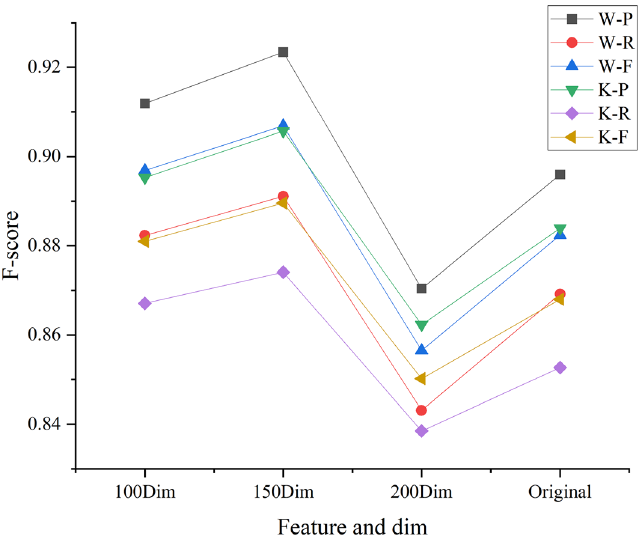
Figure 8. Effect of the different word vector dimensions of different sensors on the F-score.